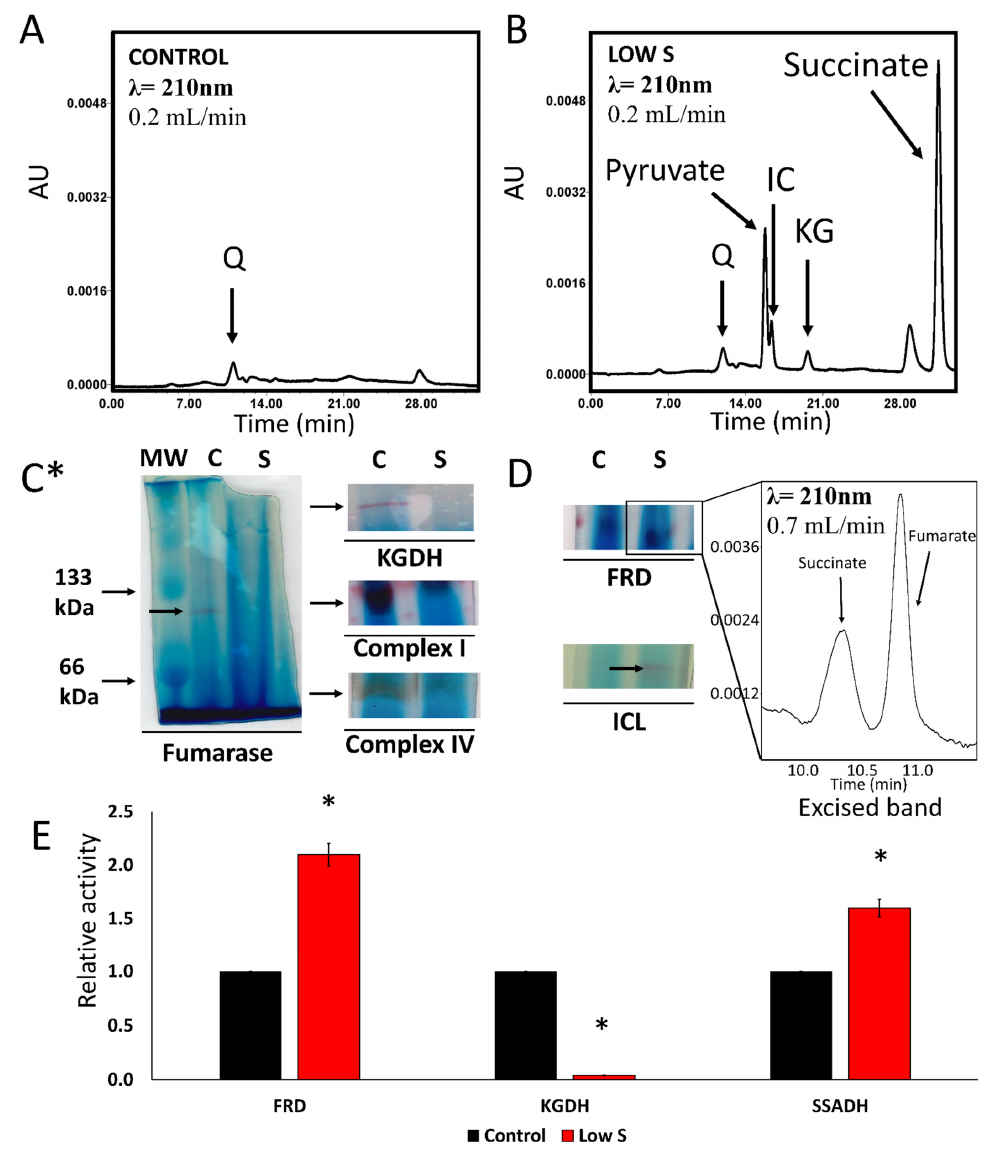
Figure 1. Oxidative stressed provoked by sulfur starvation leads to succinate accumulation in P. fluorescens . ( A ). HPLC chromatogram of a spent fluid sample from P. fluorescens grown in control conditions. ( B ). HPLC chromatogram of a spent fluid sample from P. fluorescens grown in media with no added sulfur. The X axis shows retention time in minutes and the y axis shows absorbance at 210 nm in arbitrary units (AU). ( C* ). Enzymatic activity analysis of TCA cycle and oxidative phosphorylation enzymes by Blue Native polyacrylamide gel electrophoresis (BN-PAGE). Fumarase, α -ketoglutarate dehydrogenase (KGDH) and (Complex I-IV) activities are decreased in the stressed cells. ( D ). Enzymatic activity analysis of fumarate reductase (FRD) and isocitrate lyase (ICL). FRD and ICL activities are increased under sulfur starvation. The nature of FRD was confirmed by cutting the band and incubating it in reaction buffer with 2 mM fumarate and 0.2 mM NADH. Detection of succinate was done by running the reaction mixture in the HPLC after 24 h. C = Control, S = Low sulfur. ( E ). Enzymatic assays of select enzymes with appropriate substrates by measuring the absorbance of NADH at 340 nm. The rate of reaction was calculated using the slope of absorbance change per minute. The control sample was normalized to 1 and the stressed rate was compared to it, data is shown as relative activity. (Q = glutamine, IC = isocitrate, KG = α -ketoglutarate) Data are represented as means ± standard deviation and is representative of three (3) distinct experiments. n = 3, * = p <